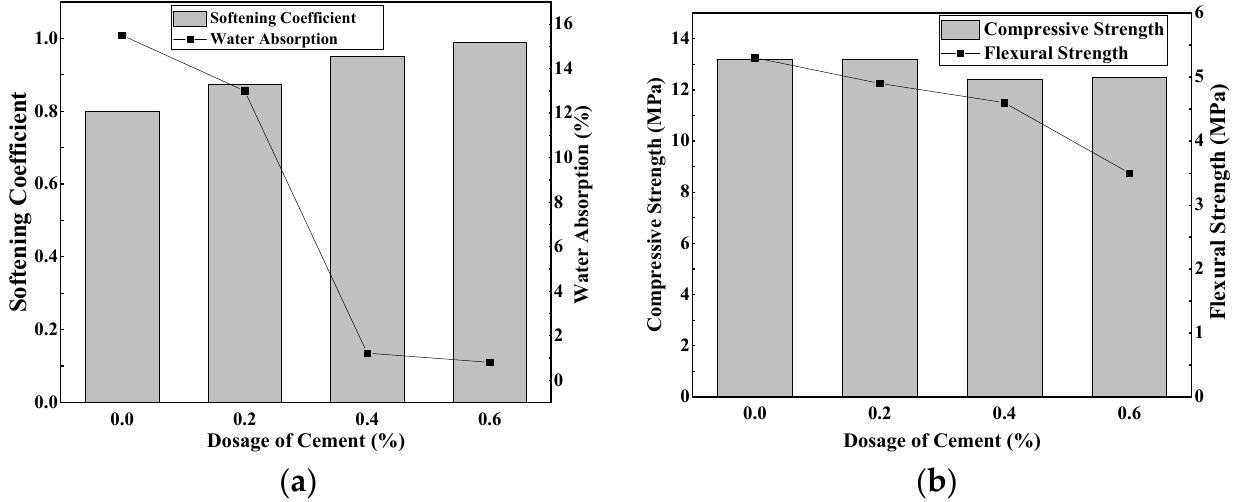
Figure 3. Influence of different cement contents on the phosphogypsum with a hydrophobic agent. ( a ) Softening coefficient and water absorption. ( b ) Compressive strength and flexural strength.